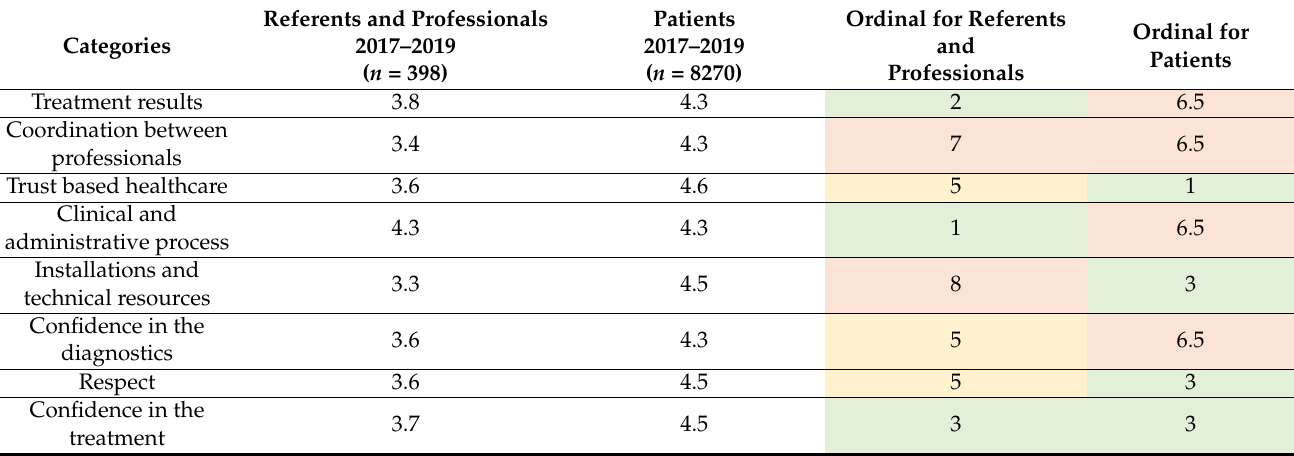
Table 4. Average scores between professionals and referents and